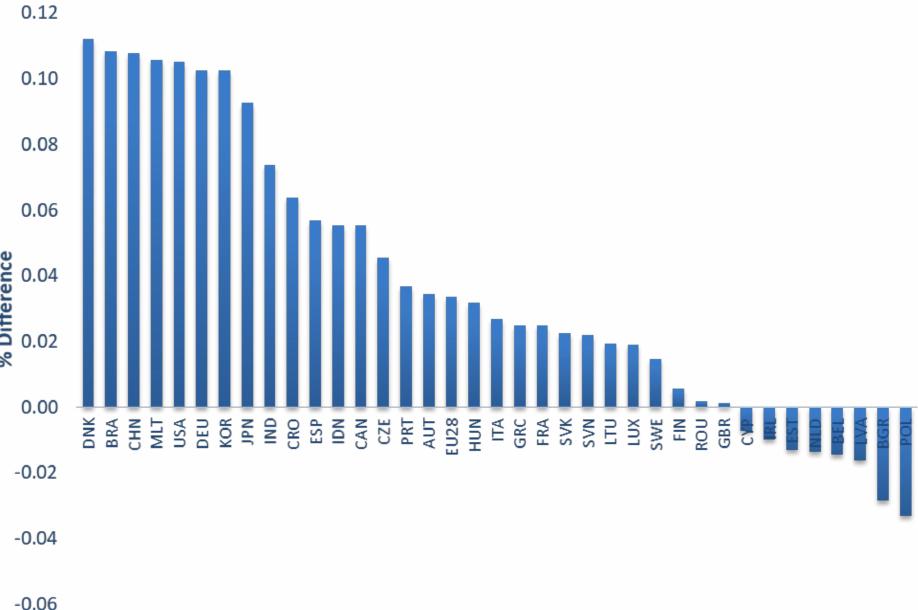
Figure 5. GDP Changes in 2DEG_GRD in 2050 (% di ff erence from 2DEG).